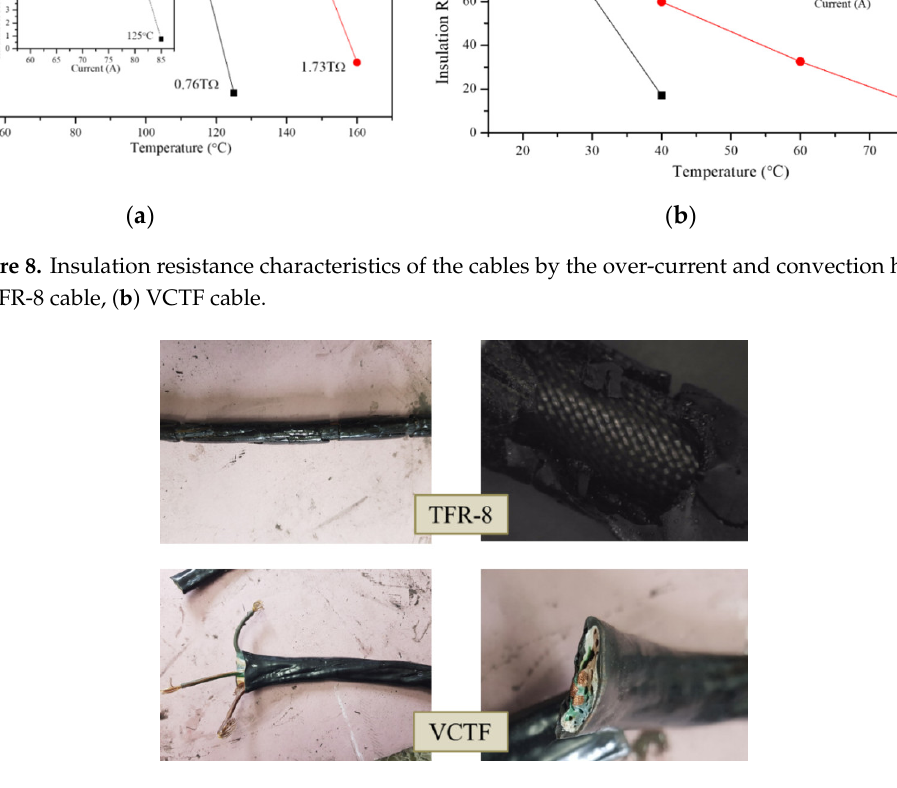
Figure 9. Photographs of the TFR-8 and VCTF cables after the over-current test.